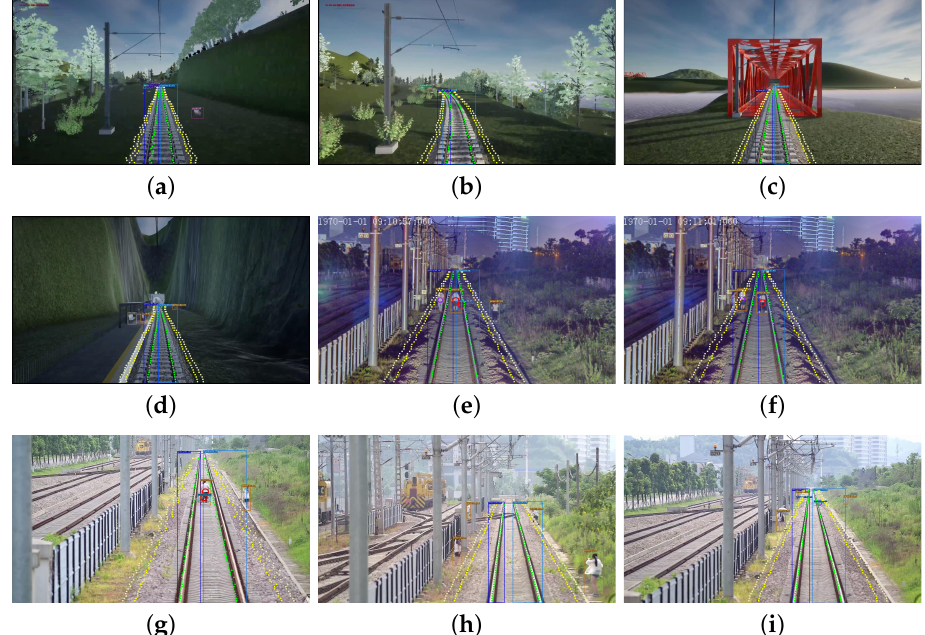
Figure 9. The visual representation of the results in our work. ( a – d ) correspond to the simulated data in our dataset, ( e , f ) correspond to data collected at night and ( g – i ) correspond to data collected during the day. The red circle indicates that the obstacle intrudes into the track area, and the purple circle indicates that the obstacle intrudes into the first-level warning area on both sides of the rail.